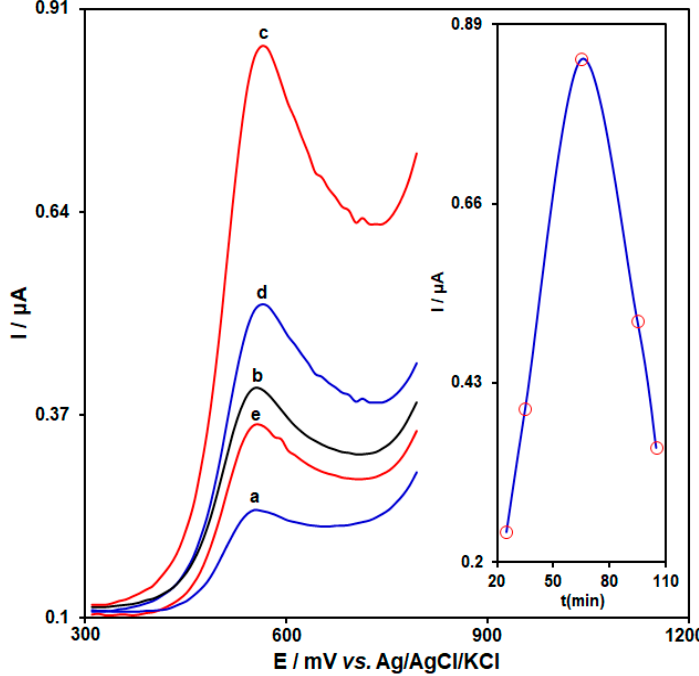
Figure 3. DPVs captured from AP/Au-NS/CPE with an aptamer concentration of 4.5 μ M in PBS (0.1 M, pH = 7.0) and variable interaction times of the aptemer with homocysteine ((a) 25, (b) 35, (c) 65, (d) 95, and (e) 105 min). Inset: a plot of peak current versus interaction times ranged from 25 to 105 min.